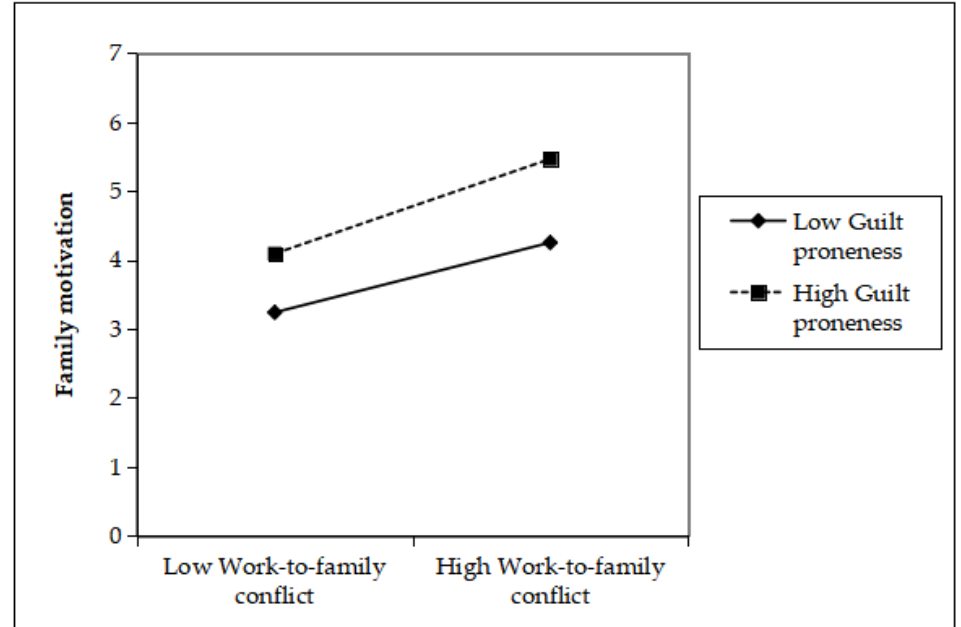
Figure 4. The Moderating Effect of Guilt Proneness.